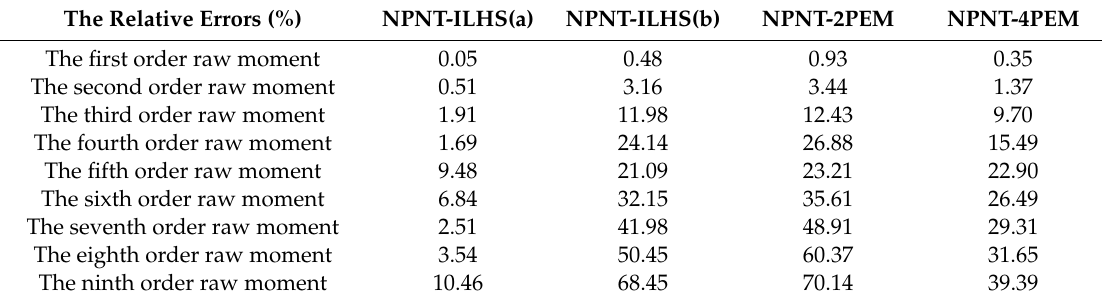
Table 6. The relative errors (%) of the first to the ninth raw moments of DC bus 2 (cid:48) s voltage magnitude.